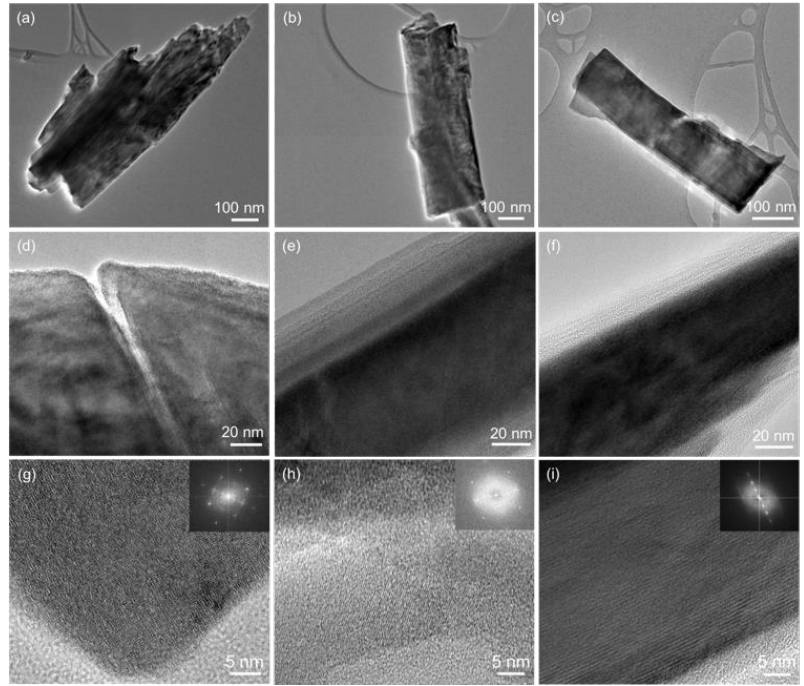
Figure 2. TEM and high-resolution transmission electron microscopy (HRTEM) images of ( a , d , g ) MoS 2 ; ( b , e , h ) MoS 2 :Eu 3+ , Tb 3+ ; ( c , f , i ) MoS 2 :Er 3+ , Yb 3+ nanosheets.